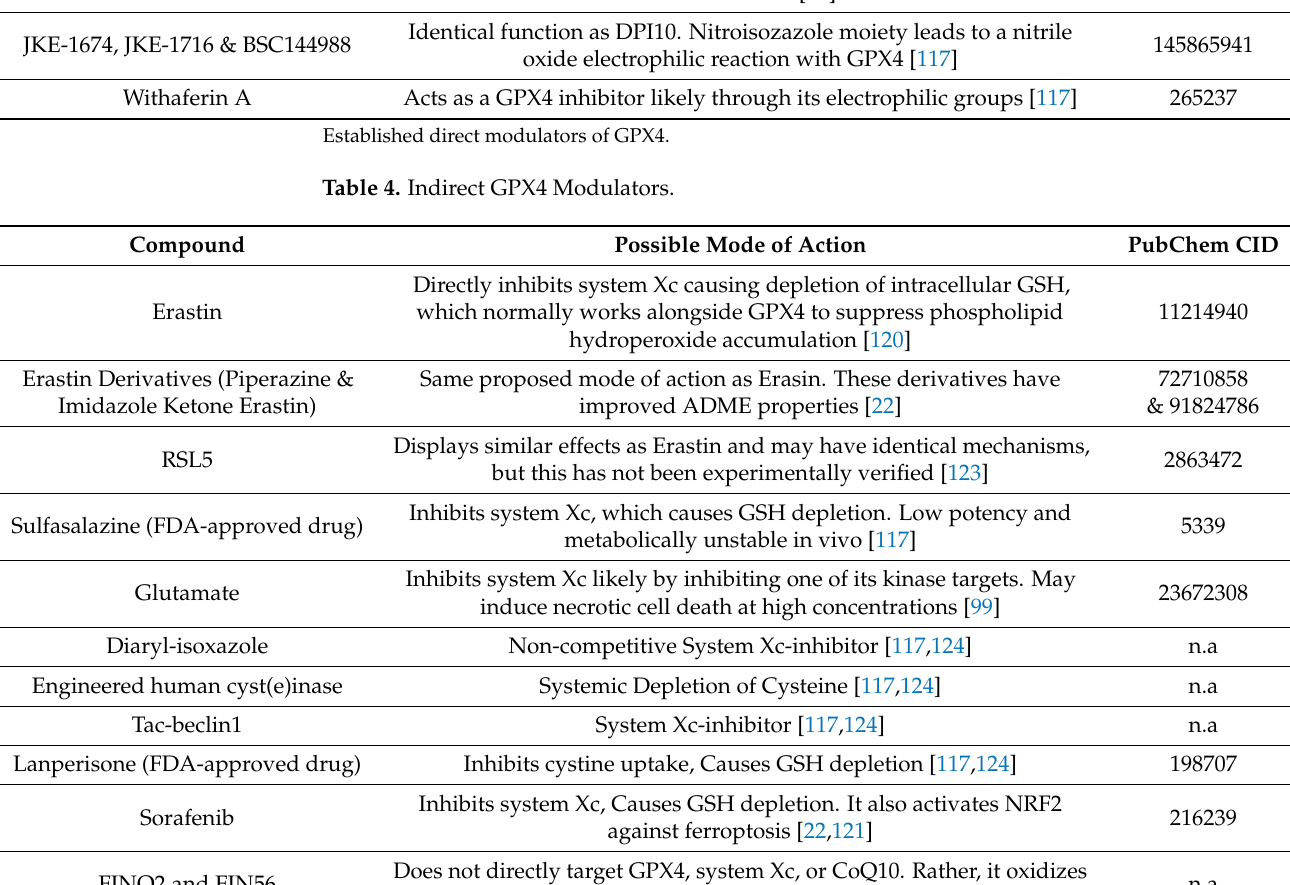
Table 4. Indirect GPX4